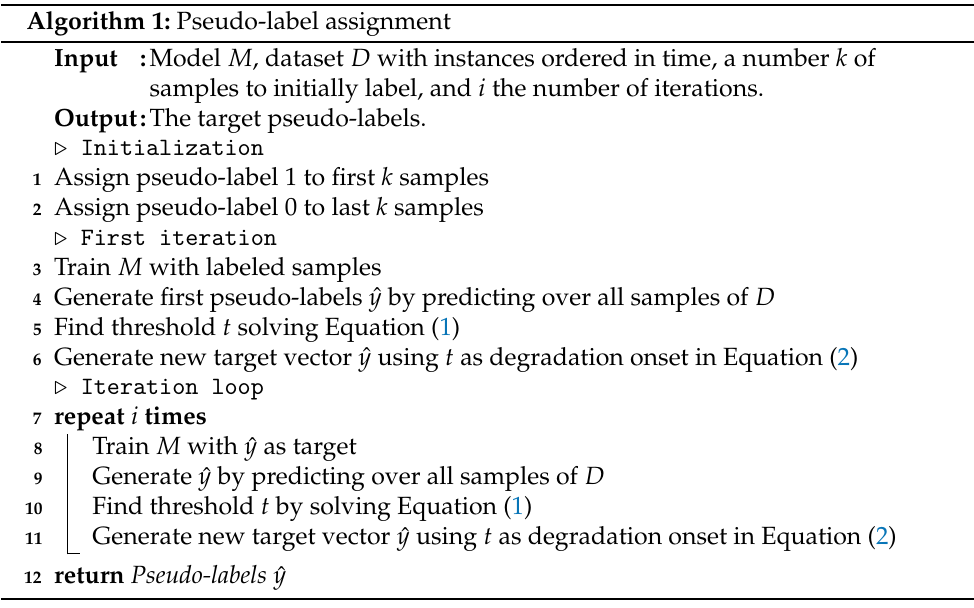
Algorithm 1: Pseudo-label